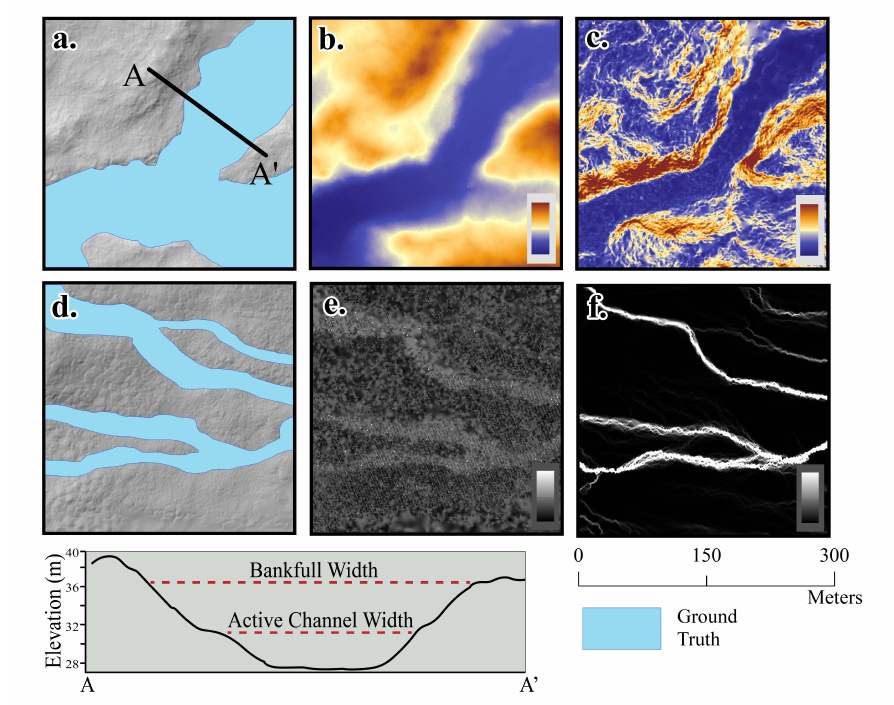
Figure 5. Examples of visual feature indicators for stream boundary segmentation. ( a ) Hillshade with stream boundary ground truth ( b ) Elevation feature raster used for manual stream boundary segmentation using linear depressions and a rapid change in elevation ( c ) Slope feature raster used for manual stream boundary segmentation using a topographic features such as rapid change in slope with inflection points on either side of the banks ( d ) Hillshade with stream boundary ground truth ( e ) Intensity feature raster used for stream identification using linear patterns of reflectivity ( f ) Flow accumulation feature raster used for manual stream segmentation using linear patterns of high flow